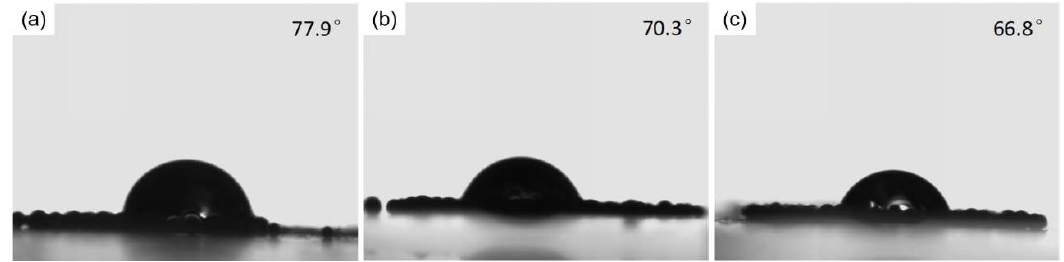
Figure 8. The water contact angles (WCAs) of ( a ) PLGA microspheres, ( b ) PLGA@PDA microspheres, and ( c ) PLGA@PDA/PEI microspheres.